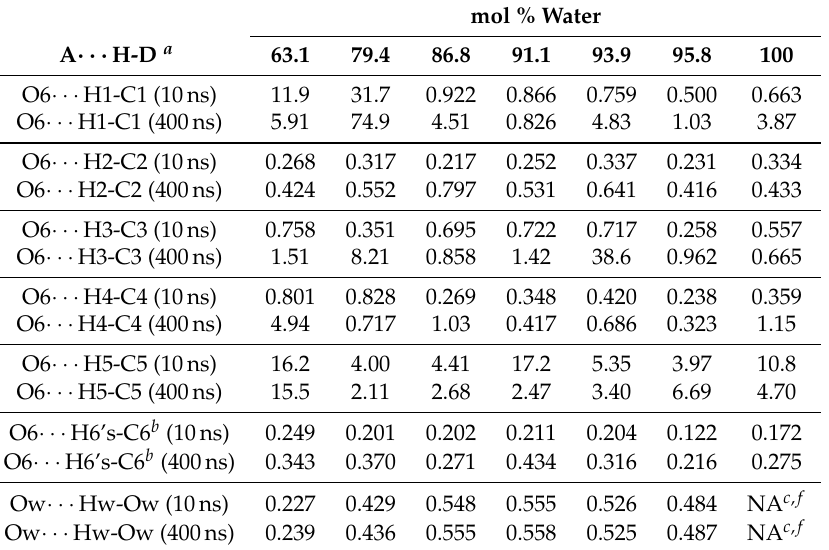
Table A4. TBPCl hydrogen bonding lifetimes (ps), Part 5 of